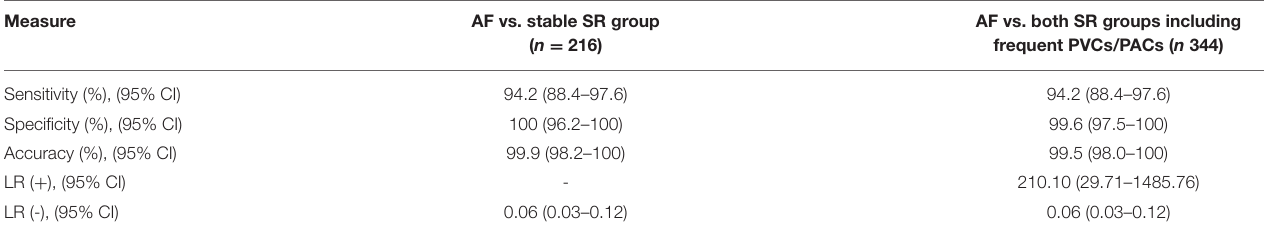
TABLE 4 | Diagnostic measures of the system combining monitoring with an automated PPG-based algorithm together with the 6-lead wearable ECG confirmation. Measure AF vs. stable SR group